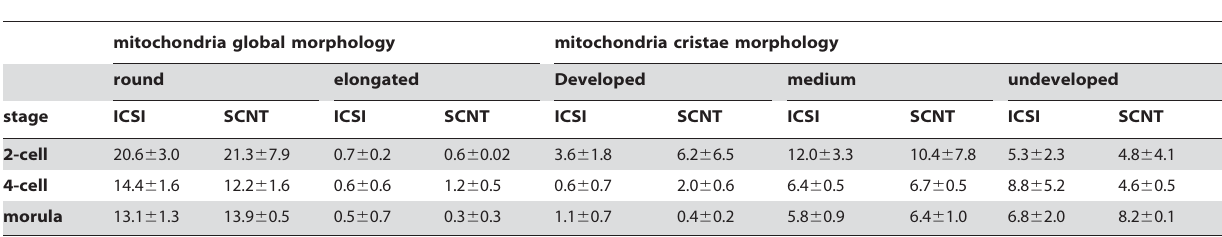
Table 1. Ultrastructural analysis of mitochondria in pre-implantation embryos.